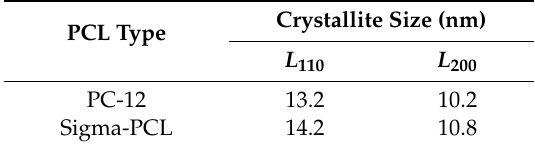
Table 2. Thermal properties of PCL tubes * from XRD